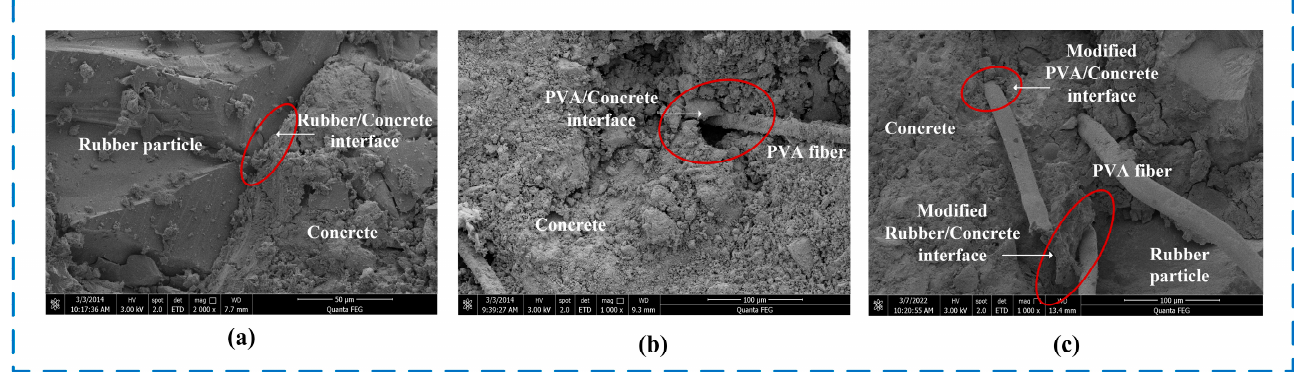
Figure 6. Micromorphology of the specimen: ( a ) Rubber concrete; ( b ) PVA-rubber/concrete; ( c ) KH560 modified PVA-rubber/concrete.